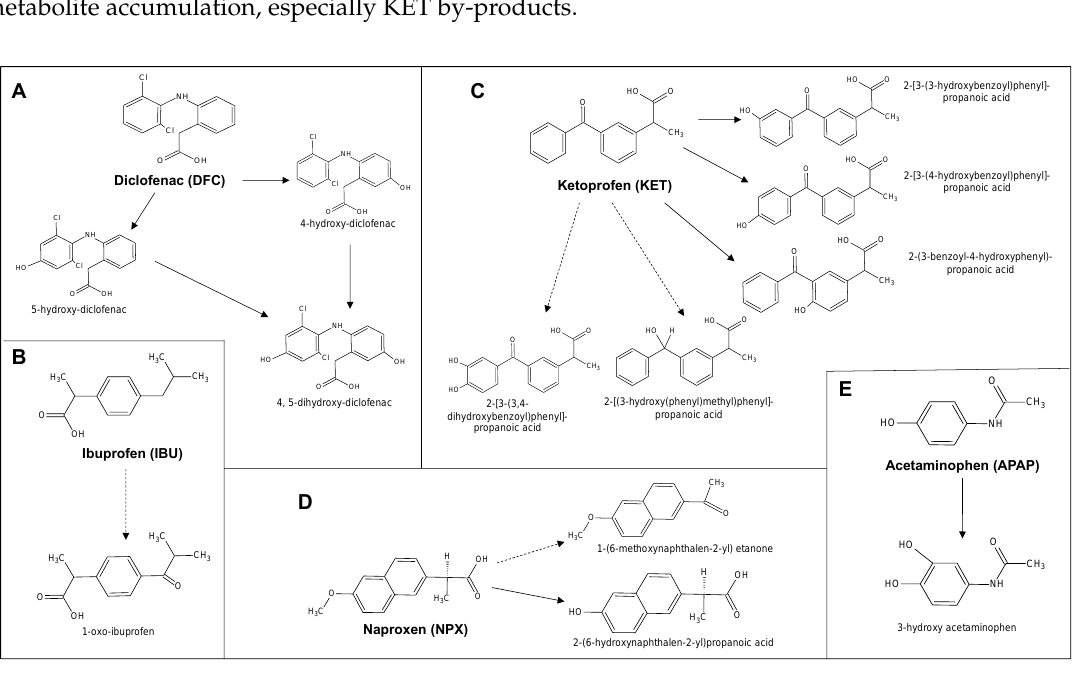
Figure 4. Representation of the partial biodegradation pathways of the tested drugs based on the different metabolites detected by ultra-high performance liquid chromatography (UHPLC) quadrupole time-of-flight (QToF) mass spectrometer. ( A ) diclofenac (DFC); (B) ibuprofen (IBU); (C) ketoprofen (KET); (D) naproxen (NPX) and (E) acetaminophen (APAP). The continuous arrow indicates direct transformation and the dashed arrow secondary transformation.